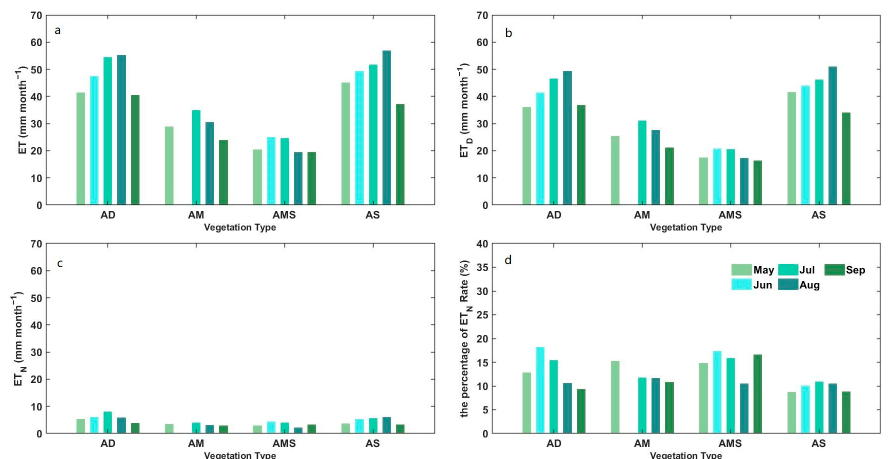
Figure 4. Monthly variation of ( a ) cumulative evapotranspiration ( ET ), ( b ) cumulative evapotranspiration in daytime ( ET D ), ( c ) cumulative nocturnal evapotranspiration ( ET N ), and ( d ) the percentage of ET N to ET of alpine ecosystems in the Qinghai Lake Basin during the growing season (from May to September) in 2019.